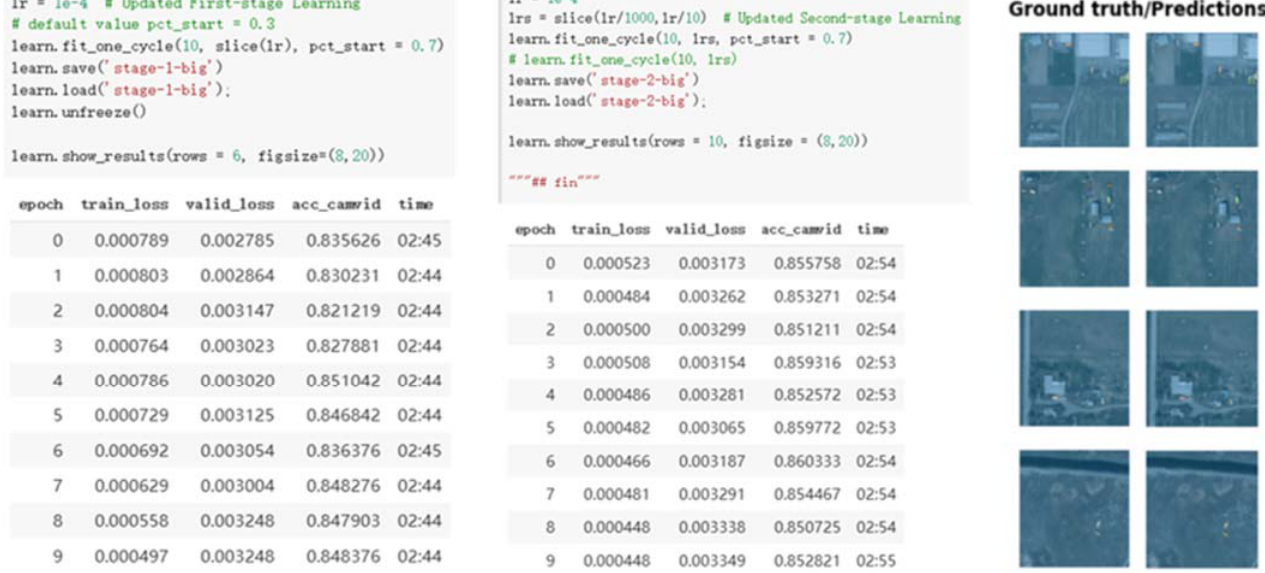
Figure 6. Sample results on detection accuracy and GT/predicted objects of two-stage learning after Figure 6 . Sample results on detection accuracy and GT/predicted objects of two ‐ stage learning after updating with FC-DenseNet 103 and applying an adjusted learning rate for online updating with FC ‐ DenseNet 103 and applying an adjusted learning rate for online VEDAI.